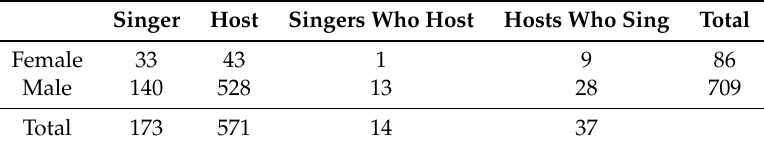
Table 2. Number of speakers and singers in the Bertsolaritza database. Singer Host Singers Who Host Hosts Who Sing Total Female 33 140 528 Total 173